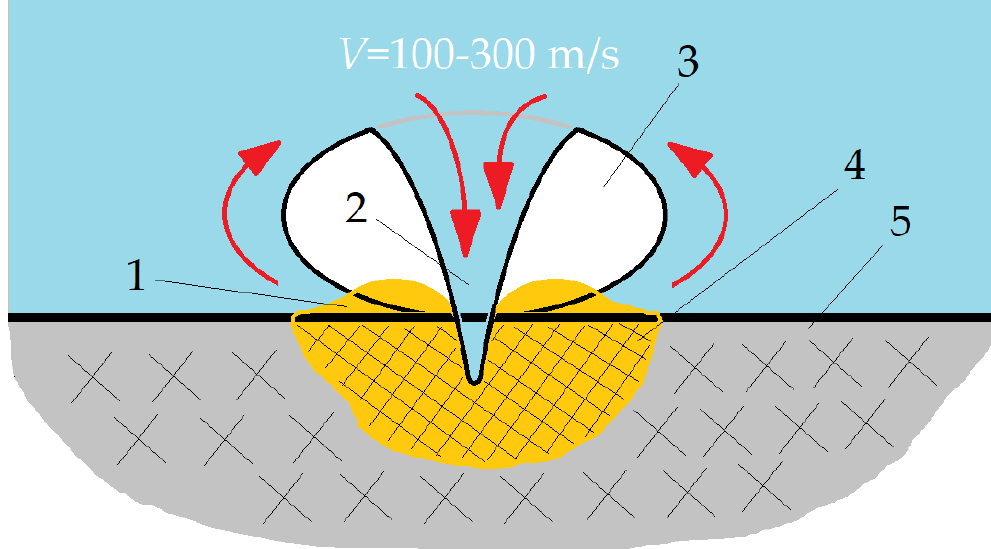
Figure 6. Scheme of cavitation (erosion) wear, where ( 1 ) is extruded by cumulative microjet material at the stage of plastic deformation; ( 2 ) is a cumulative microjet; ( 3 ) is a collapsing bubble; ( 4 ) is plastic deformation zone; and ( 5 ) is surface to be machined.